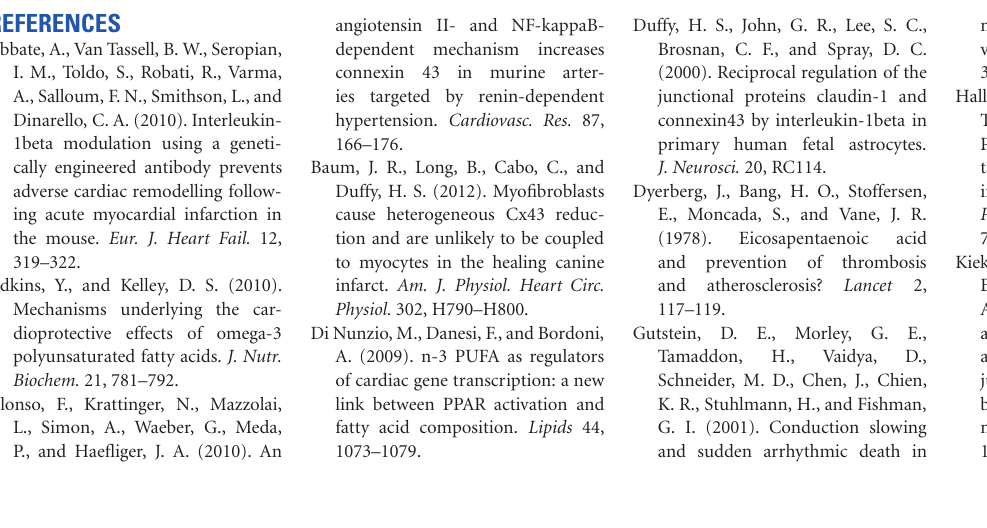
(A and B upper trace, n = 3). In contrast, mice fed diets enriched in DHA were unable to be induced to VT with the same prematurity ( B , lower trace, n =